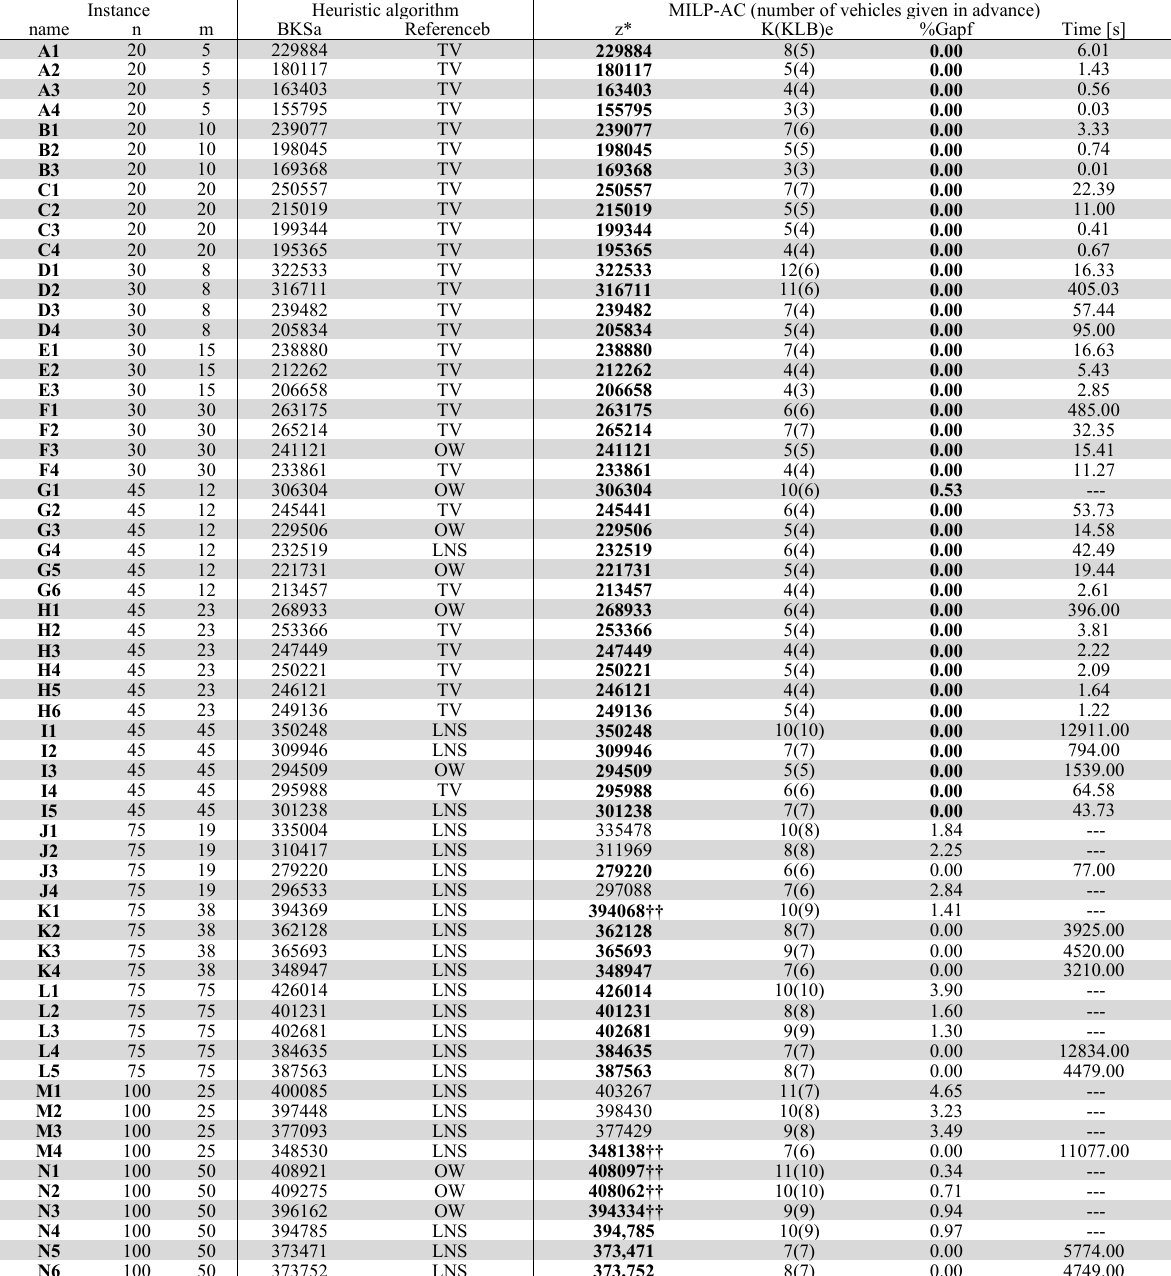
Computational results for the VRPB cases from Goetschalckx & Jacobs-Blecha (1989) with the Euclidean distances rounded to integers Instance Heuristic algorithm MILP-AC (number of vehicles given in advance)